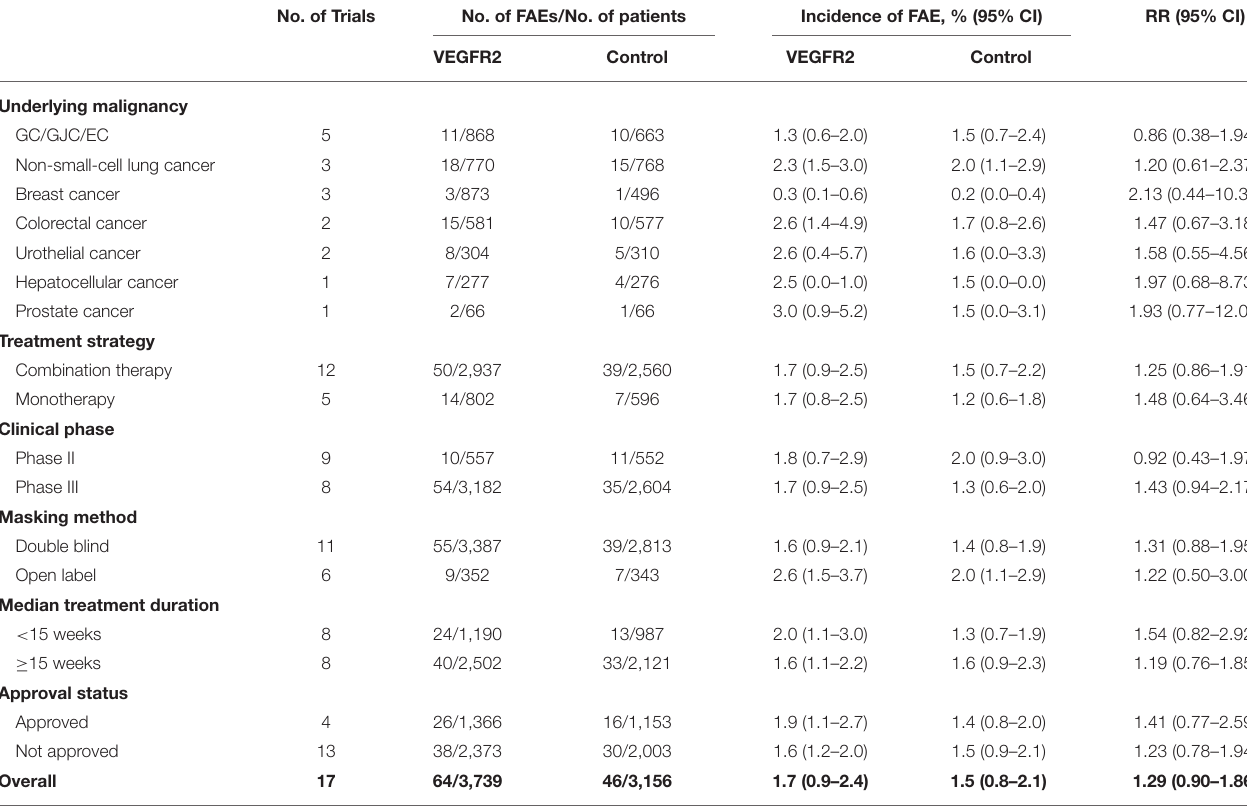
TABLE 2 | Incidence and relative risk (RR) of FAE associated with VEGFR2-targeted agents according to underlying malignancy, treatment strategy, clinical phase, masking method, median treatment duration, and approval status. No. of Trials No. of FAEs/No. of